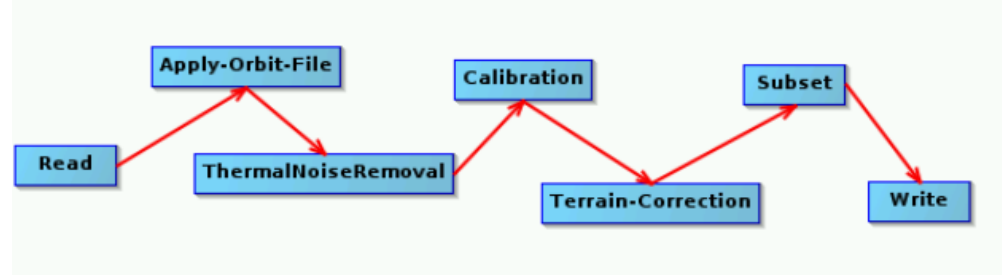
Figure A2. Batch used to generate each image of the stack in ESA SNAP (Sentinel Application Software).